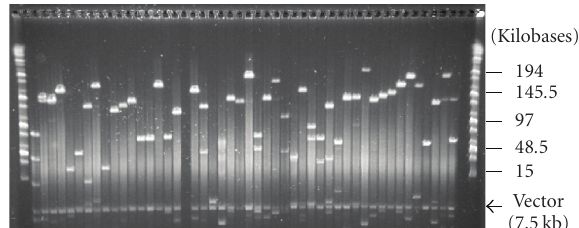
Figure 1: Insert DNA analysis of random BAC clones from the Camellia sinensis Hind III BAC library, CSBCBa, by pulsed- field gel electrophoresis. DNA samples were digested with Not I and separated by pulsed-field gel electrophoresis with ramp pulse time of 5–15 s at 6V/cm at 14 ◦ C in 0.5 × TBE bu ff er for 16 h. Markers used are midrange I (outside lanes). The 7.5-kb common band corresponds to the cloning vector pIndigoBAC536 Swa I (pAGIBAC1).